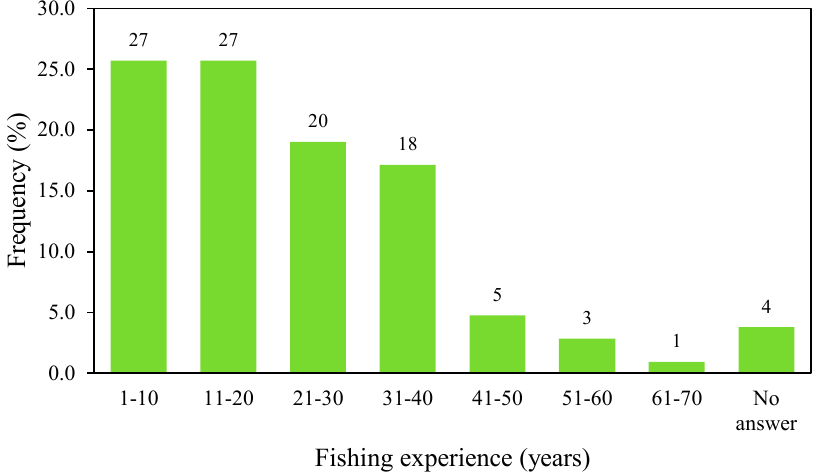
Figure 2. Fishing experience of the surveyed Azorean fishers in this study. The numbers above the columns indicate the absolute sample size ( n ).